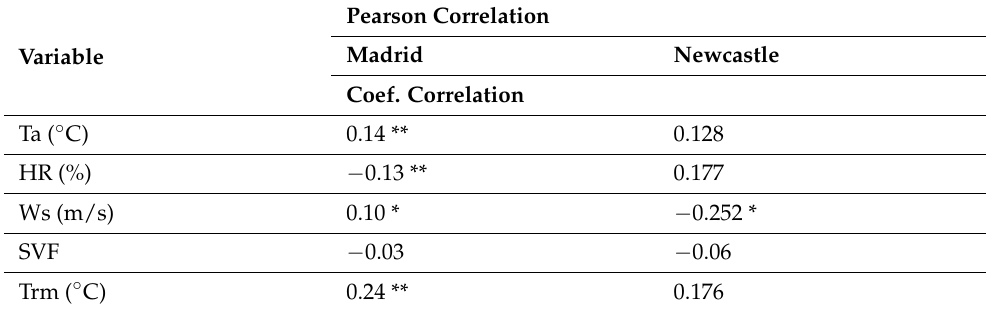
Table 4. Correlation between thermal comfort and environmental variables for Madrid and Newcastle.